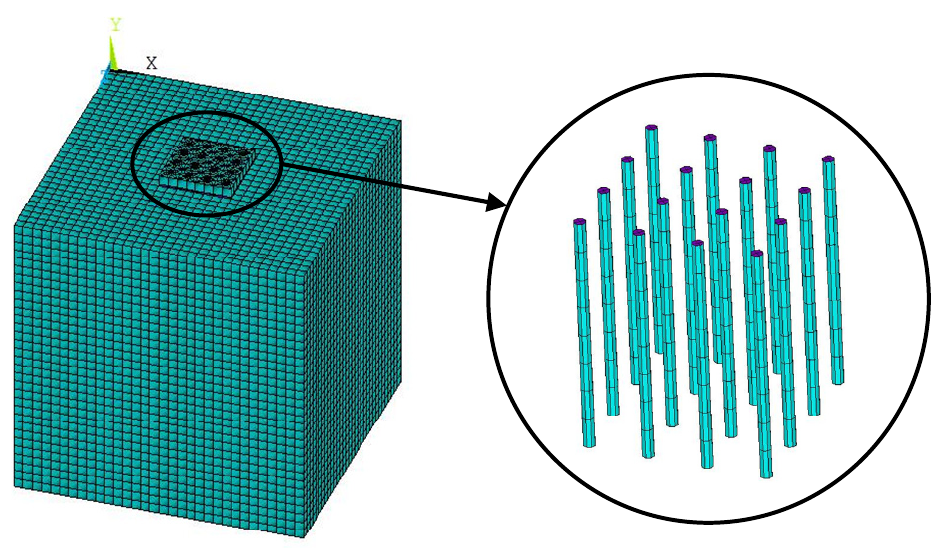
Figure 1. FE model of the cap–pile group–surrounding soil system.